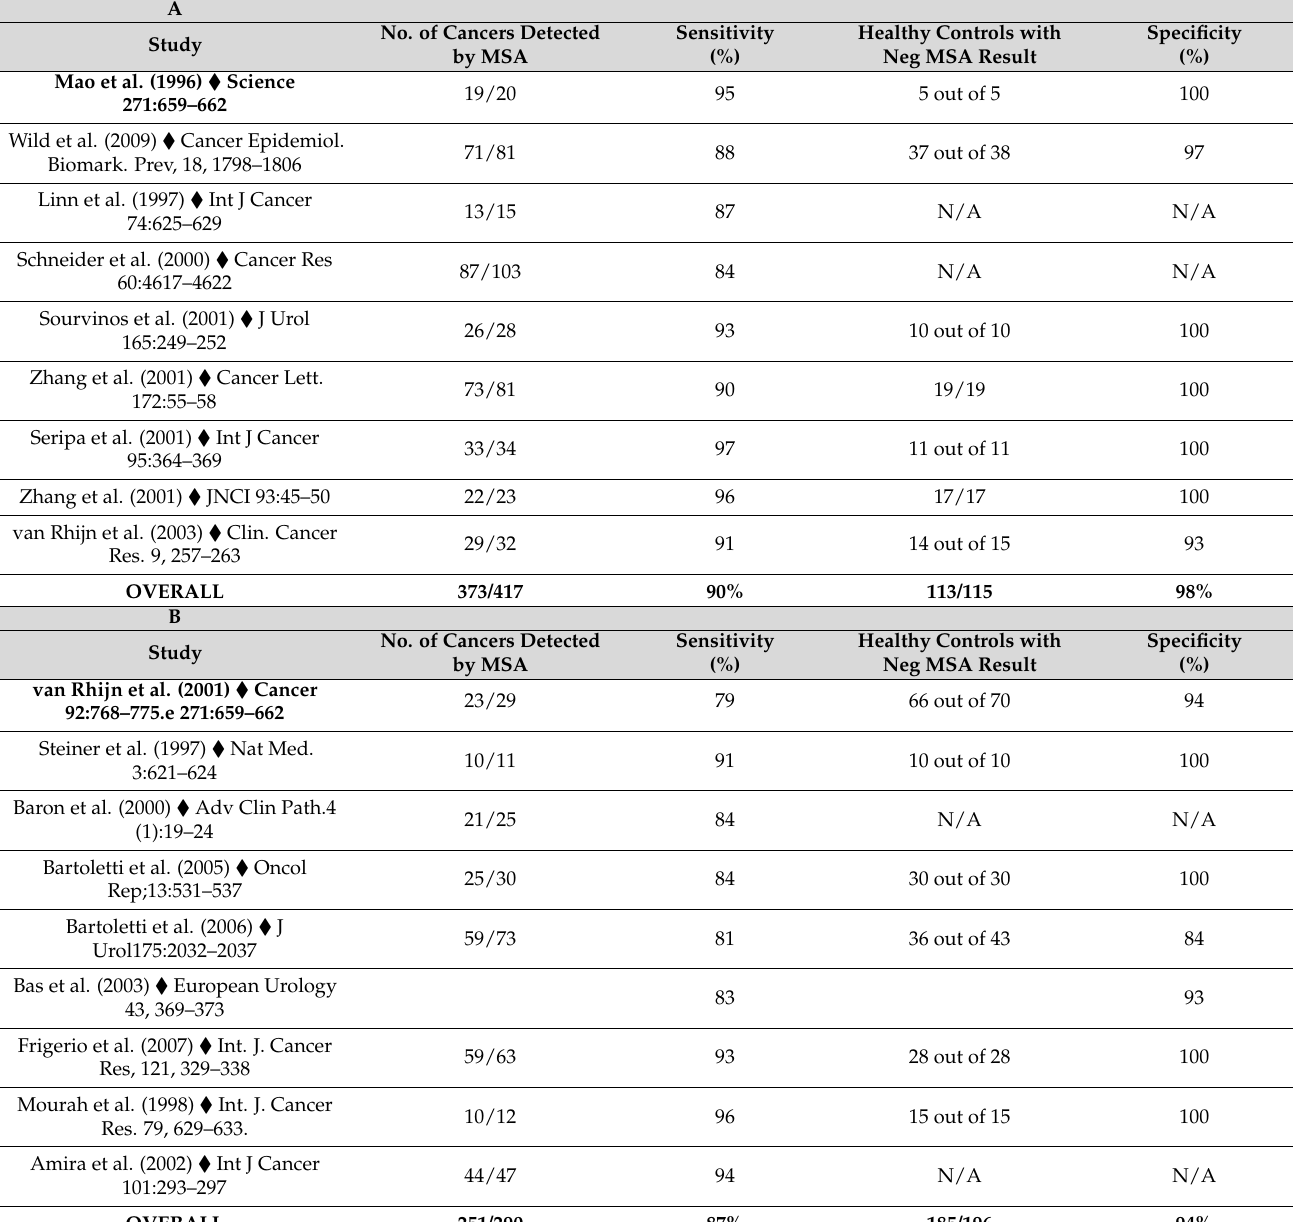
Table 1. A : List of prior publications and sensitivity/specificity analysis on MSA study for the initial detection of bladder cancer. B : List of prior publications and sensitivity/specificity analysis on MSA study for the recurrent disease detection (surveillance setting) of bladder cancer. No. of Cancers Detected Sensitivity Specificity